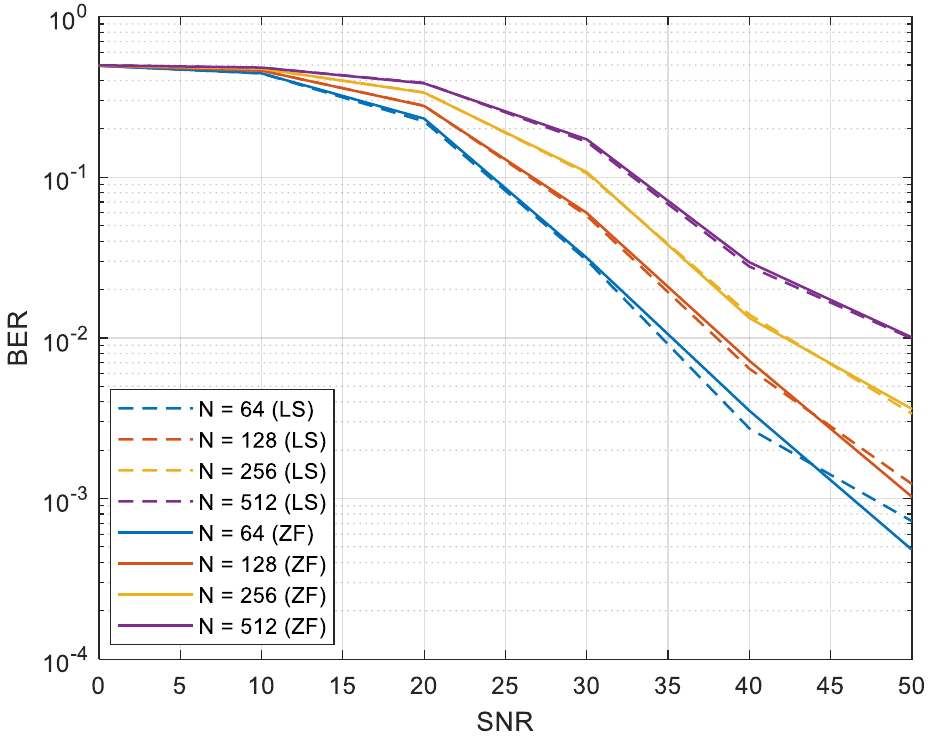
Figure 9. BER of CP-OFDM when using the LS and ZF equalizers as a function of the number of subcarriers with a transmitter-receiver distance of 500 m and the number of pilots one-fourth the number of subcarriers. Table 2. BER performance for 64, 128, 256, and 512 subcarriers at a fixed distance of 500 m.